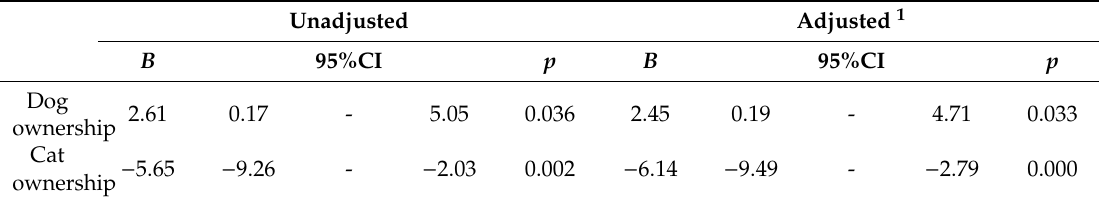
Table 2. Multiple linear regression analysis for well-being at age 12.